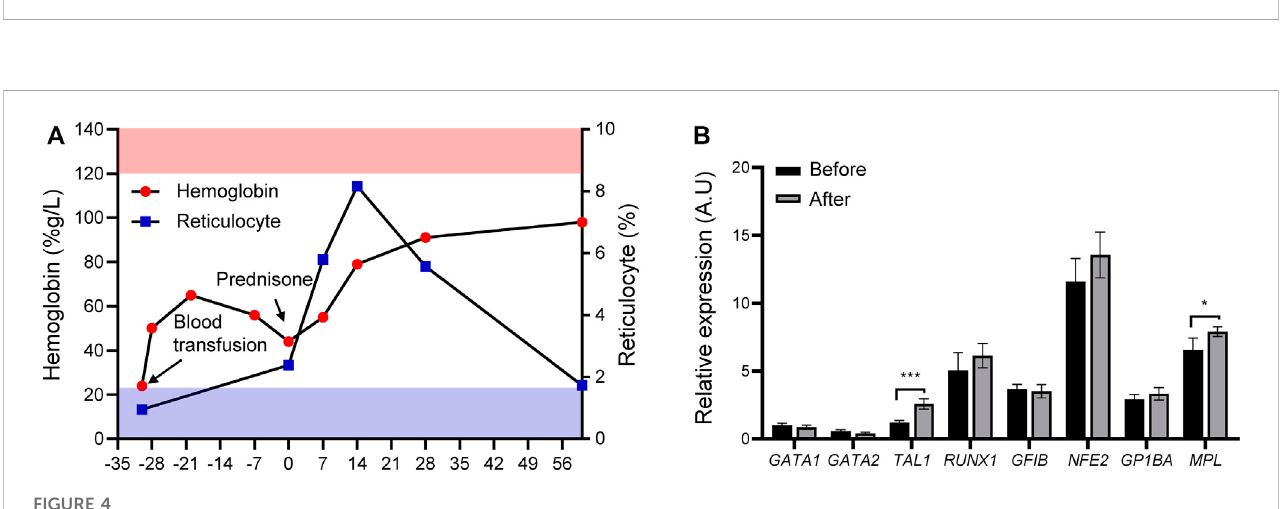
FIGURE 3 ValidationofGATA1splicing. (A) RDDSpredictedanabnormalsplicingmodelafter GATA1 (C) 220+1G > Cmutation.Linesindicateintrons,andblueboxes indicatenormalexons, respectively.Orangeboxesindicateaberrantexons.Redarrowsshowedthemutationsite. (B) Primerdesignandtranscriptiondiagram of long- and short- GATA1 form. (C) mRNA level of short GATA1 isoform in peripheral blood mononuclear cells from the patient before and after therapy, as well as from healthy control subjects (HC), **** p < 0.0001.